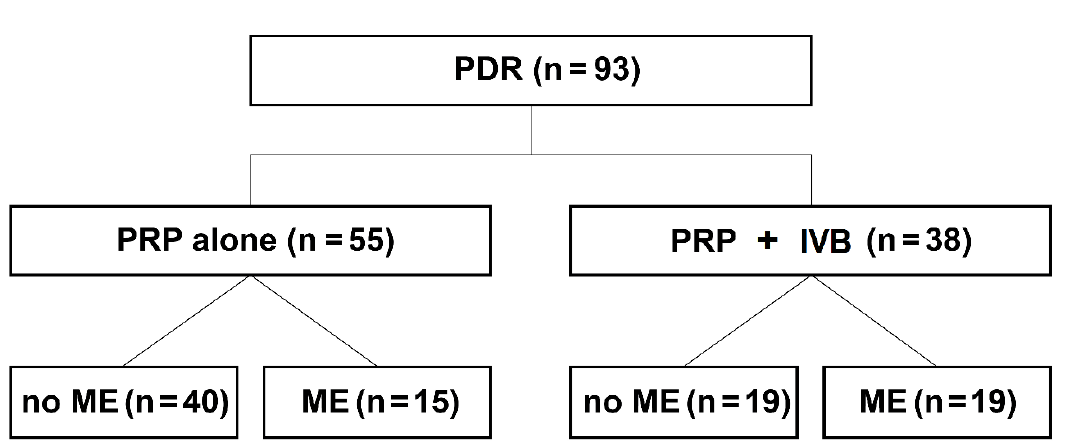
Figure 1. Patient enrollment and study design. In total, 93 eyes of 74 patients with PDR were enrolled. Of these, 55 eyes underwent only PRP and 38 underwent PRP with preoperative IVB injection. Each group was further classified according to the presence of ME at baseline. IVB: intravitreal bevacizumab, ME: macular edema, PRP: panretinal laser photocoagulation, PDR: proliferative diabetic retinopathy. Table 1. Baseline clinical characteristics of patients with proliferative diabetic retinopathy who underwent panretinal photocoagulation with (combination group) or without (PRP only group)